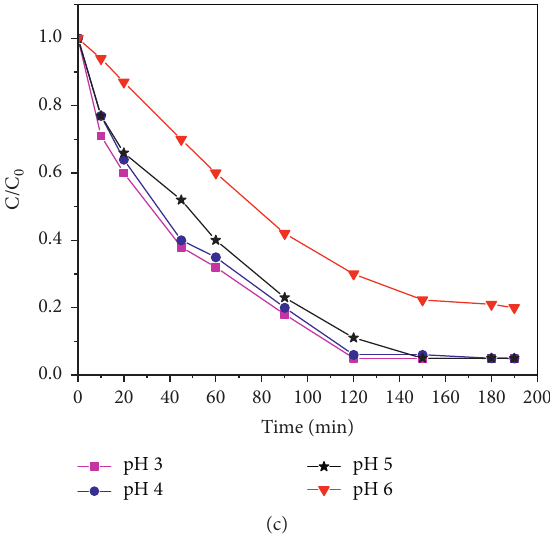
Figure 7: Photo-Fentondegradation of MB in different H 2 O 2 concentrations (a), catalyst dosages (b), and initial pH conditions (c). Reaction conditions: [MB] � 50 mg/L, [catalyst] � 2.5 g/L, [H 2 O 2 ] � 14.68, and natural pH, except for tested condition.